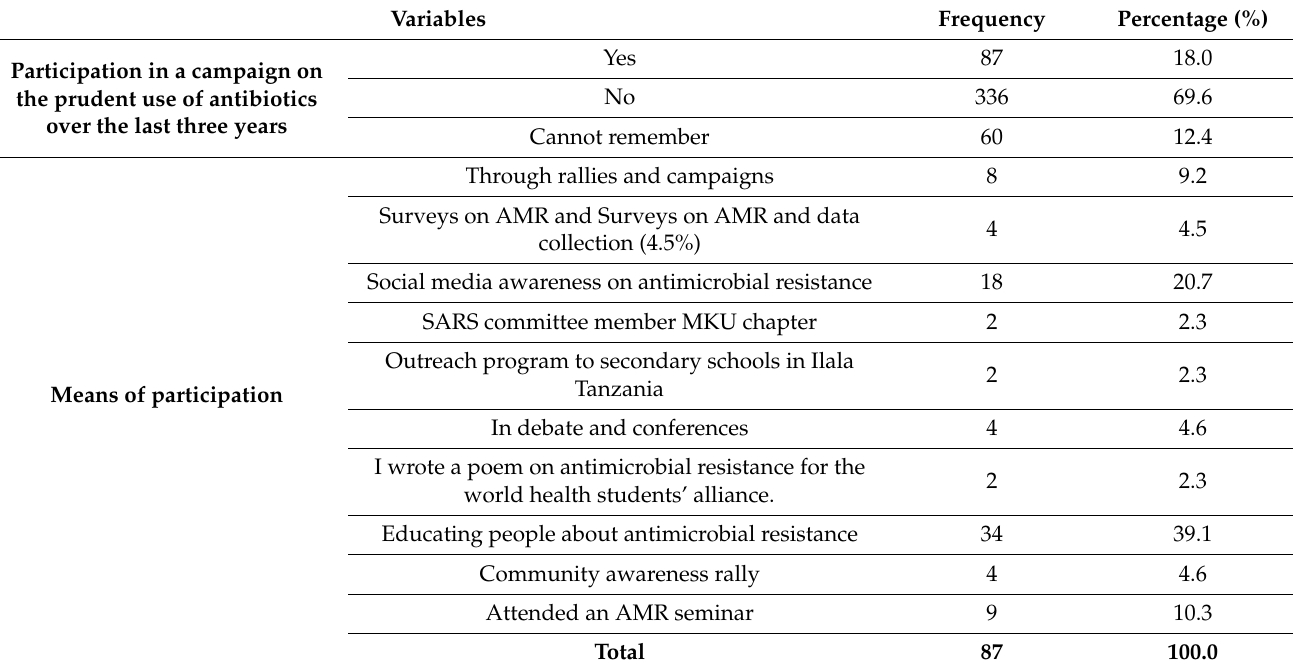
Table 2. Students’ participation in public health campaigns on prudent antibiotic